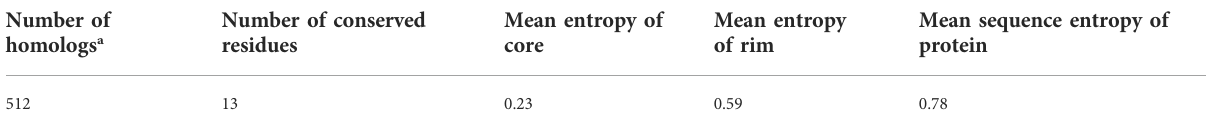
TABLE 2 Sequence entropy data for the interface residues in a subunit of human NF-kappaB p52 (PDB code, 1a3q).